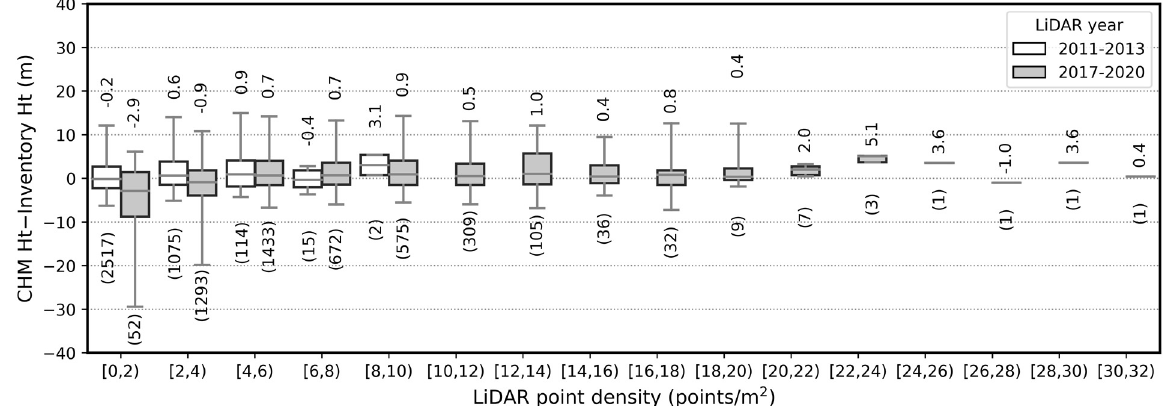
Figure 11. Height measurement error with respect to LiDAR point density. Boundaries of upper and lower whisker are the ninety-seventh and third percentiles. The number above each box plot is median, and the number below box plot is number of data points. CHM: canopy height model; Ht: height.